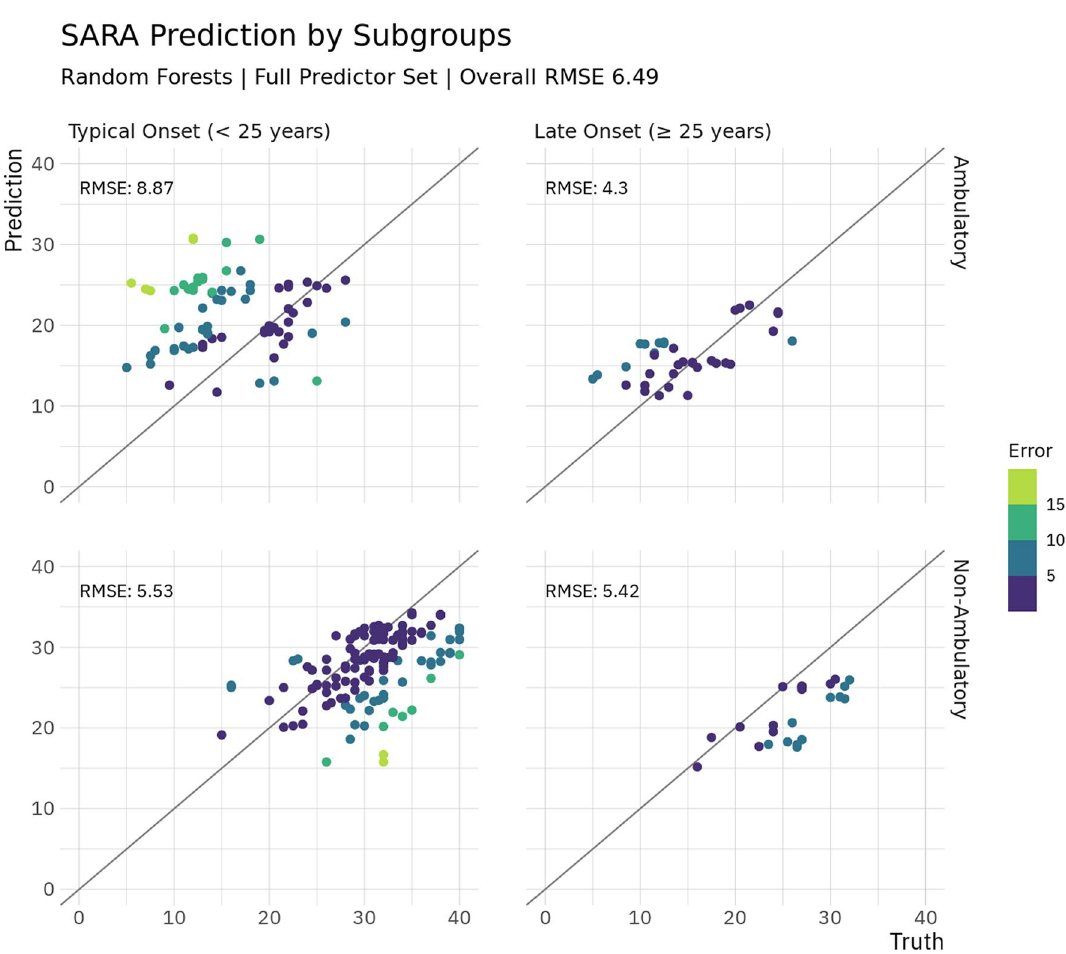
Figure 2. SARA Prediction by Subgroup. Predictions are shown grouped by age of onset and ambulation, where non-ambulatory is defined as being permanently wheelchair bound. For each section of the grid the RMSE in the subgroup is given. Perfect predictions would have all values on the diagonal lines.